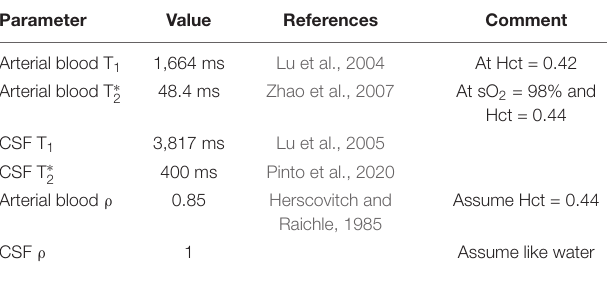
TABLE 1 | Magnetic resonance (MR) parameters for simulation at